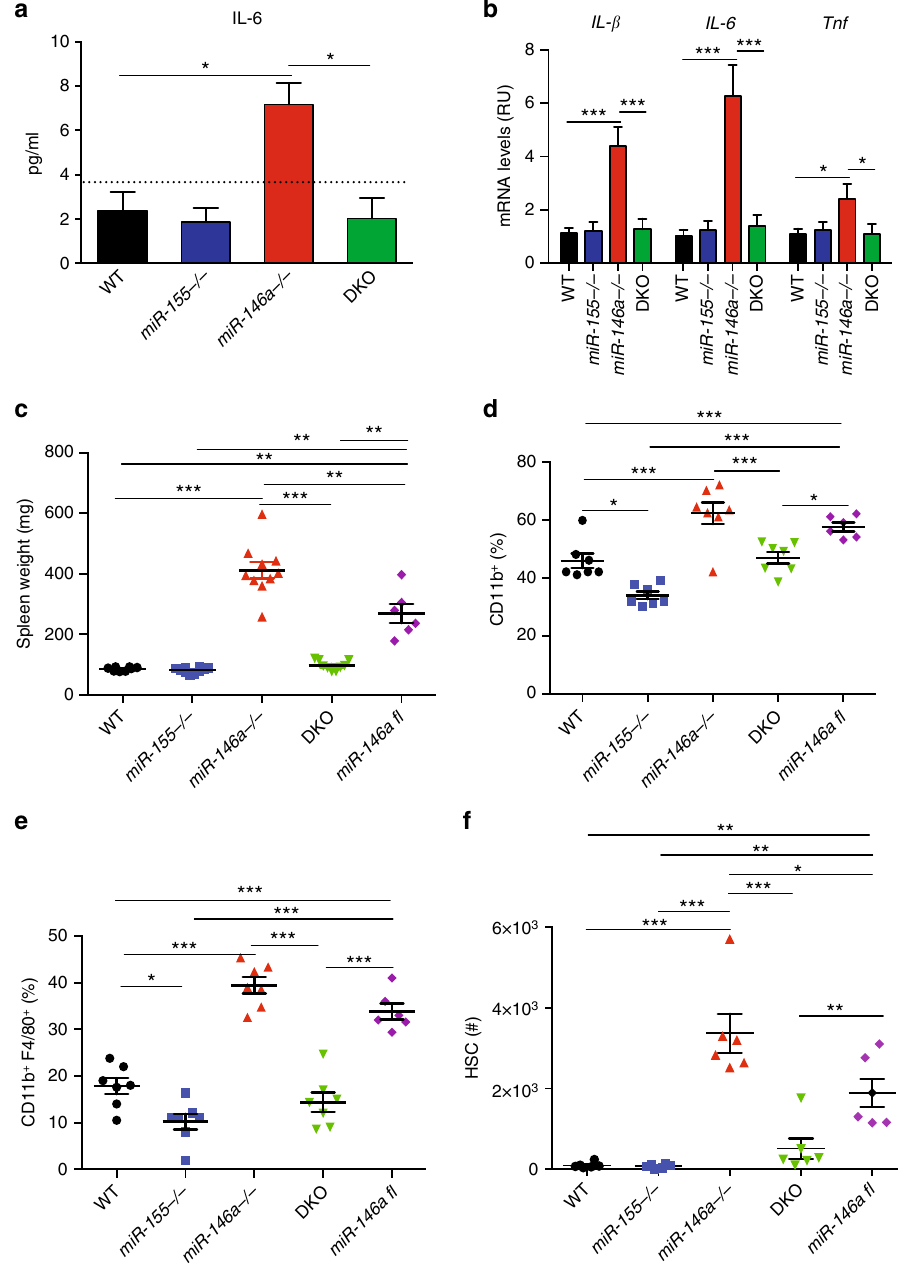
Fig. 1 miR-155 is required for myeloproliferation and extramedullary haematopoiesis in aged miR-146a − / − mice. a , b Twelve-month-old WT, miR-155 − / − , miR-146a − / − and double knock out (DKO) mice were analysed for serum IL-6 levels ( a ), spleen mRNA levels of IL-1b , IL-6 and TNF ( b ). c – f Twelve-month- old WT, miR-155 − / − , miR-146a − / − , DKO and LyzM-Cre miR-146a fl / fl mice were analysed for spleen weight ( c ), relative macrophage percentage in peripheral blood ( d ) and spleen ( e ), as well as extramedullary haematopoiesis by HSC quanti fi cation in spleen ( f ). N = 10 ( a , b ); N = 7 ( c , d ) per group, from at least two independent experiments and are represented as mean ± SEM. * p < 0.05, ** p < 0.01 and *** p < 0.001 using one-way